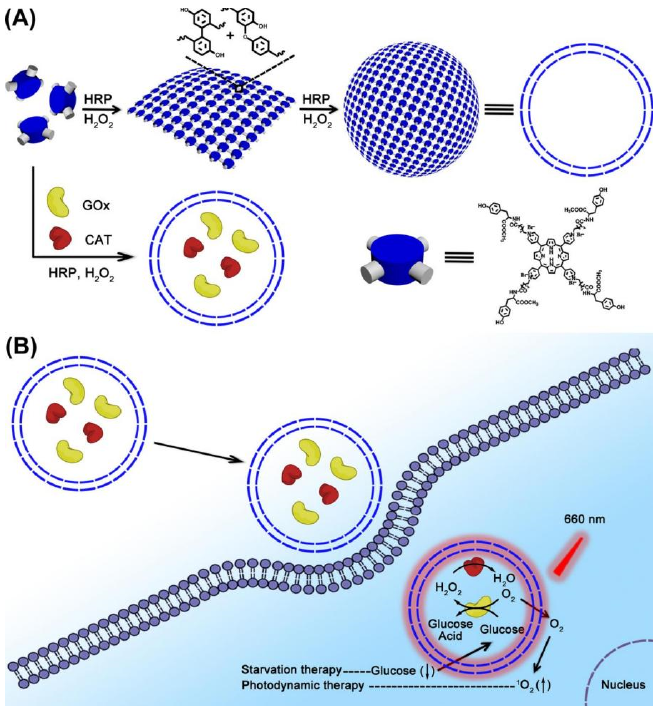
Figure 1. ( A ) The formation of nanocapsules and GOx/CAT-NCs. ( B ) The synergistic effects of GOx/CAT-NCs for starvation therapy and PDT under infrared irradiation.